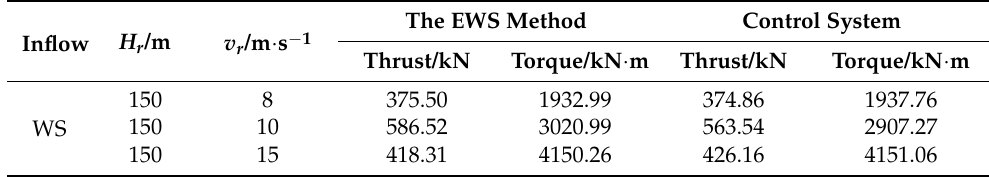
Table 6. The rotor speed, blade-pitch angle, and aerodynamic loads under different methods.